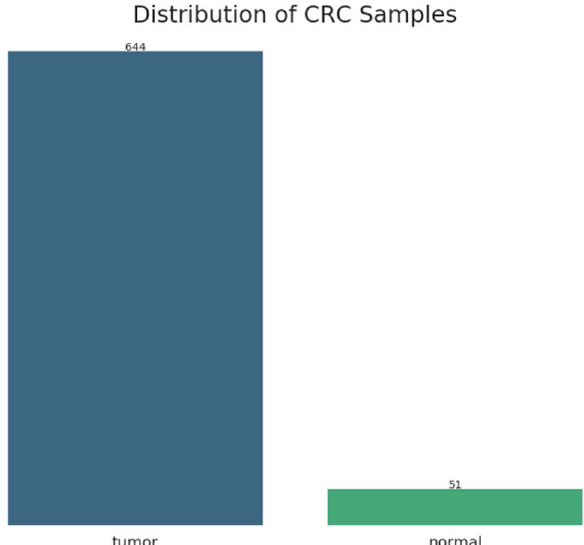
Figure 2. Distribution of CRC tumor and normal tissue samples in the working dataset. Blue color shows the number of CRC samples, green colour shows the normal tissue samples.